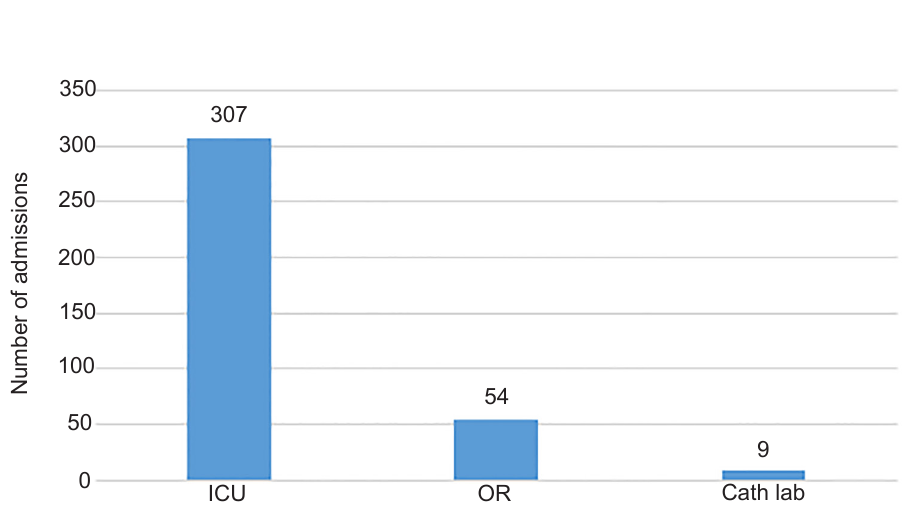
Figure 2A. Admission critical care location of mistriaged patients. ICU, intensive care unit; OR, operating room; Cath Lab, catheterization